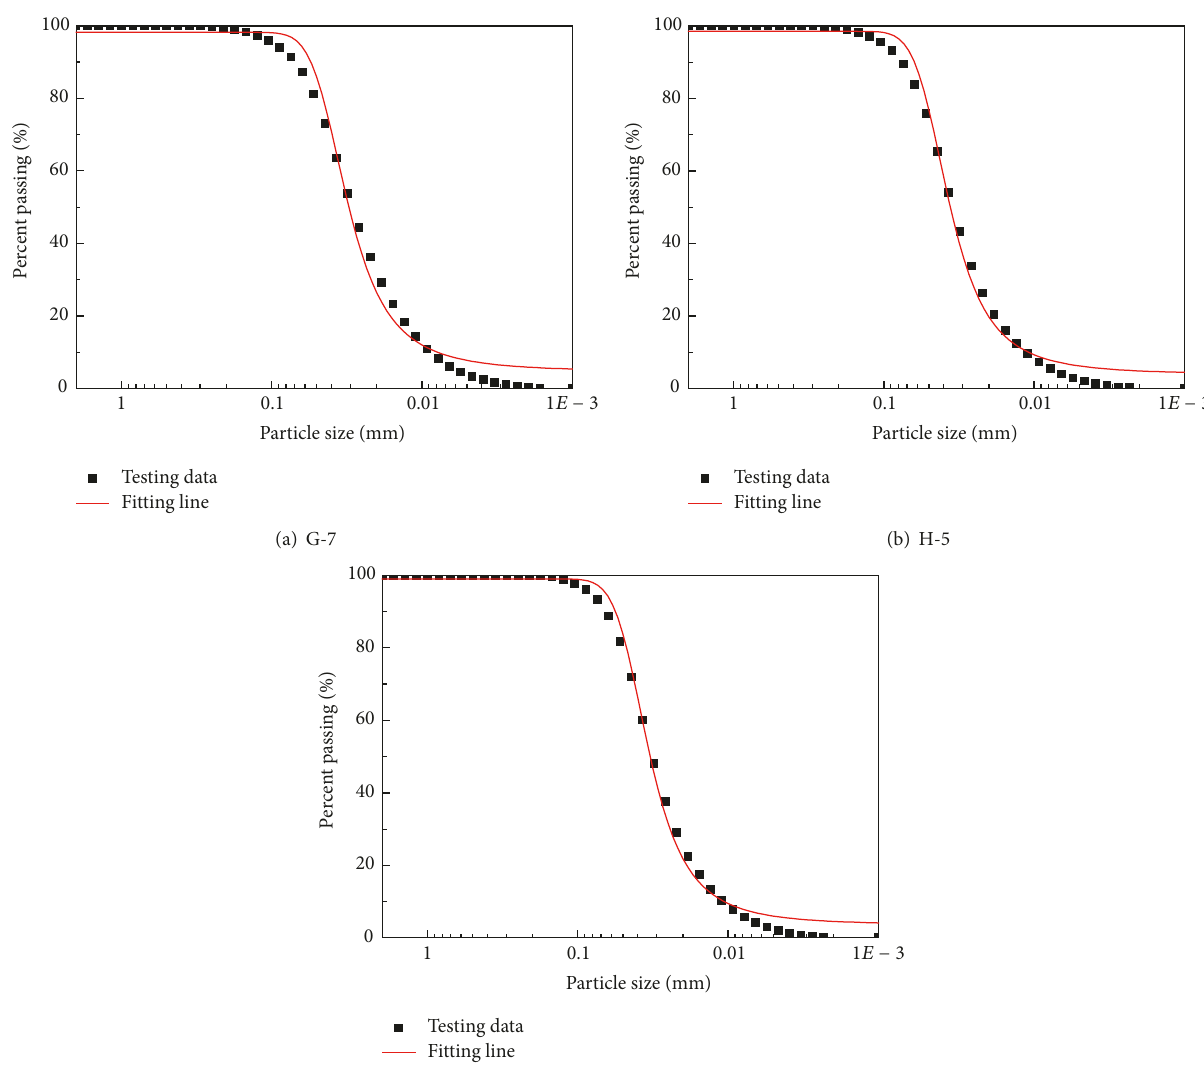
Figure 6: Performance of empirical model fitted to LD particle size